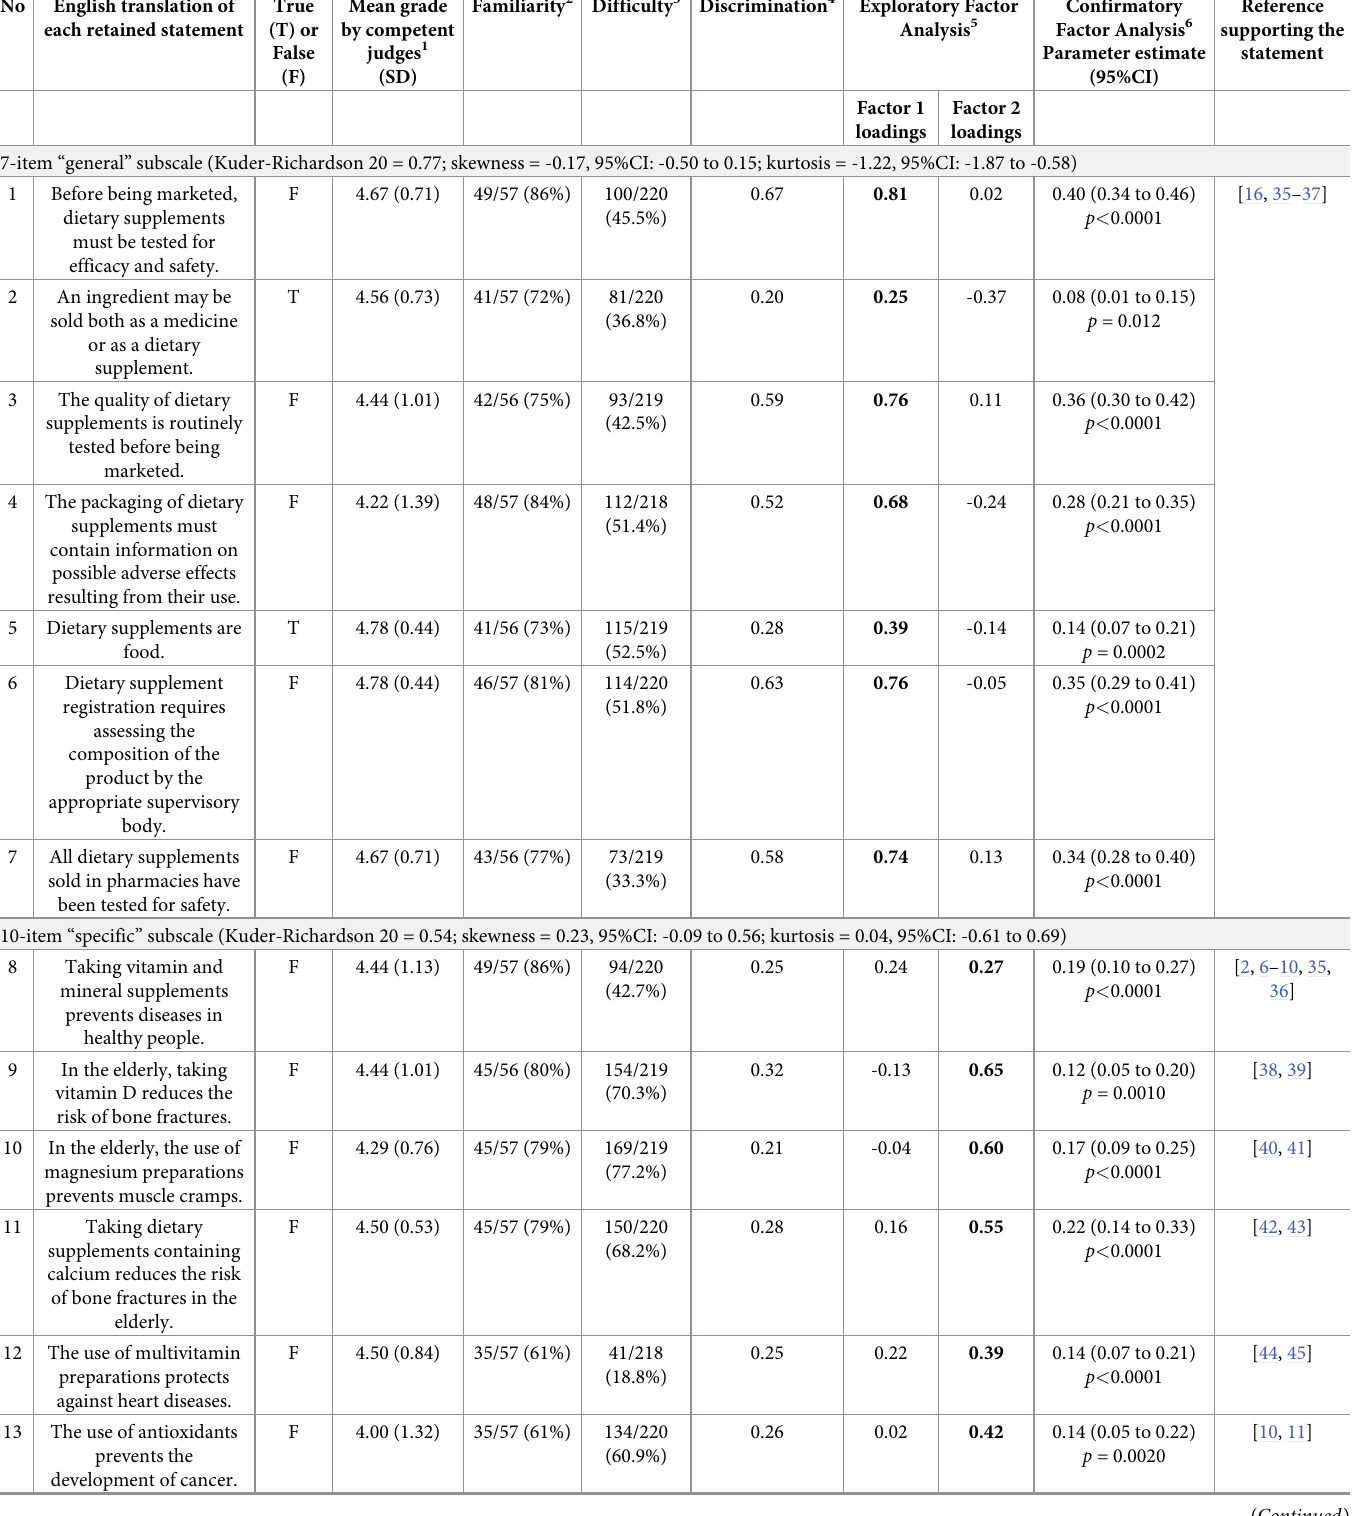
Table 2. Psychometric properties of the items in the knowledge about dietary supplements (KaDS)